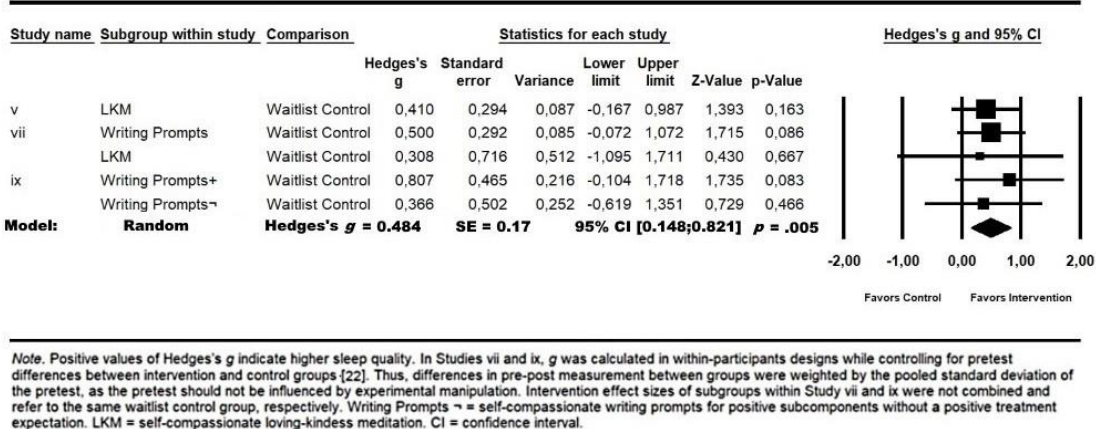
Figure 2. Meta-analysis results for SC-intervention effects on SQ of three studies.